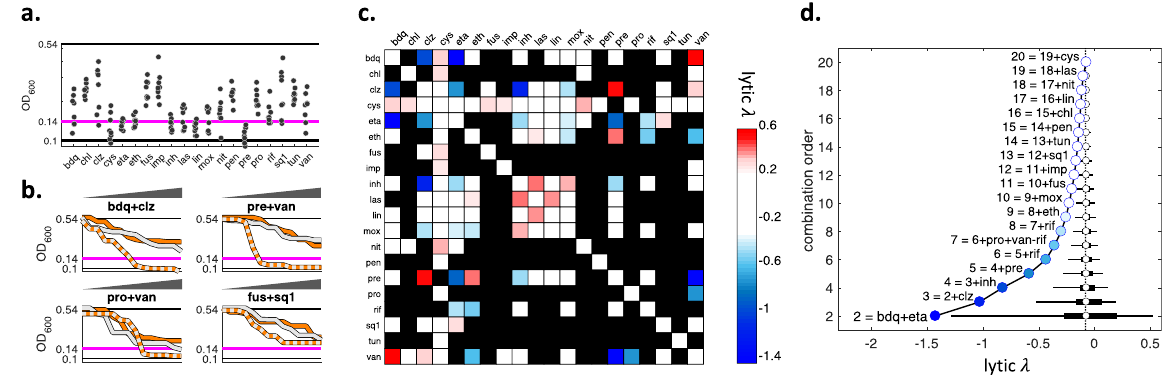
Figure 2. Lytic interactions among 20 antibiotics against M. tuberculosis . ( a ) OD600 readings at the top concentrations for 20 individual drugs are shown. The cells have an OD600 of 0.14 in Day 0 (magenta line) and untreated cells grow to an OD600 of 0.54 by day 5 (top black line). At the highest concentration of some drugs, the OD600 drops below 0.14 and can be as low as 0.1, OD of media with no cells (bottom black line). For example, cys, eta, inh, lin and pre each reduce the cell population below the magenta line. We used OD = 0.14 as initial cell number, OD = 0.1 as no cells, and OD = 0.12 as the phenotype where 50% of the cells are lysed. The concentration of a drug that results in 50% lysis is defined as LC50 (50% lytic concentration). ( b ) Pairwise lytic interaction examples. We used the same methodology to measure static λ scores to measure lytic λ scores, after two modifications: we used LC50 for score calculation; when 50% lysis was not observed in neither singles nor the combination, we were unable to calculate a lytic λ score. In each subplot, single drugs are shown with white and orange lines, combination is shown with a two-color line. bdq + clz and pre + van was previously shown to have static synergy. These pairs also have lytic synergy since each pair has a lytic effect while neither of the singles do. Static and lytic synergy do not always co-occur. For example, pro + van does not have static synergy, however it has lytic synergy. fus + sq1 has static synergy but has no lytic synergy. ( c ) Heatmap of lytic interaction scores among 20 antibiotics. Blue, white or red indicate synergy, additivity or antagonism, respectively. Black squares are pairs for which lytic λ was not calculable. Among 190 pairs considered, only 9 were found to have lytic synergy ( lytic λ < − 0.5). ( d ) The effect of combination order on the distribution of lytic interaction scores. Description and interpretation are identical to Fig.